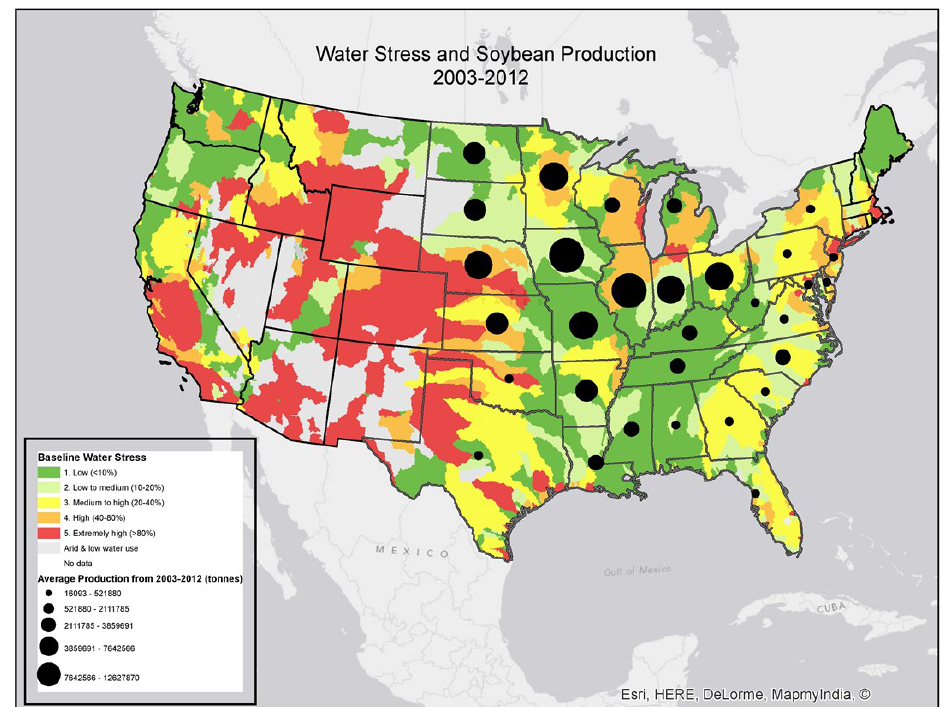
Figure 4. Water Stress and Soybean Production Source: U.S. Geological Survey National Water Information System, https://waterdata.usgs.gov/nwis [9].